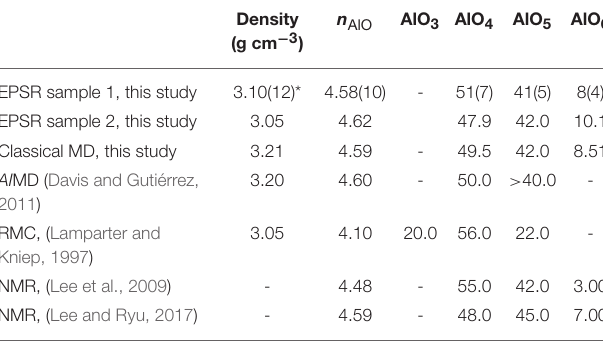
TABLE 3 | Summary of average Al-O coordination number and speciation (%) of amorphous alumina thin films obtained using r 2 = 2.5